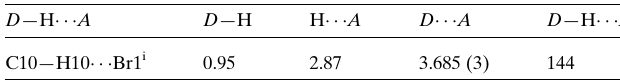
Table 1 Hydrogen-bond geometry (A˚ , (cid:5) ) for (I).